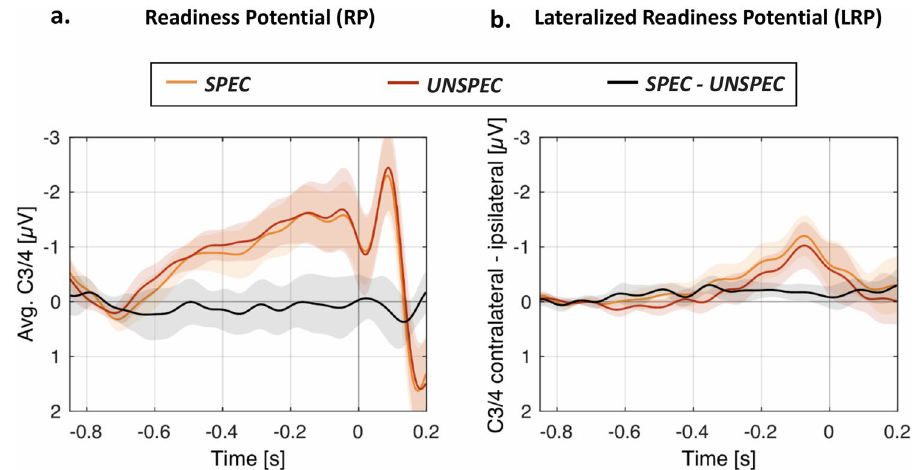
Figure 5. (L)RP results. Grand-average ERPs incl. 95% confidence intervals (shown in transparent colours) display the pre-stimulus activity in the SPEC and UNSPEC conditions, as well as the SPEC—UNSPEC differences, for the Readiness Potential (RP; a ) referring to an average of C3 and C4 electrodes, and the Lateralized Readiness Potential (LRP; b ) referring to the contralateral–ipsilateral condition differences. Figure generated in MATLAB, version R2017a (http:// www. mathw orks.